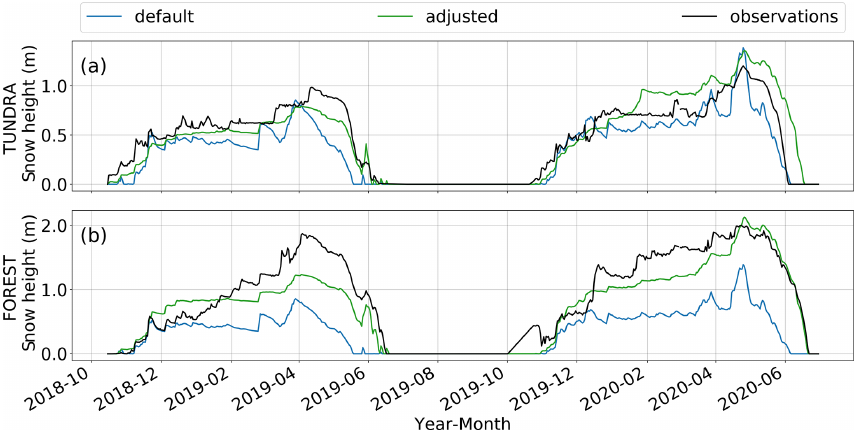
Figure 9. Evolution of simulated and observed snow heights during winters 2018–2019 and 2019–2020 at (a) TUNDRA and (b) FOREST. Two different simulations are shown: the default version of Crocus and the adjusted version, in which modifications to the compaction and snowfall modules are activated at the two sites. At FOREST, a blowing snow module is implemented to account for snow transport by the